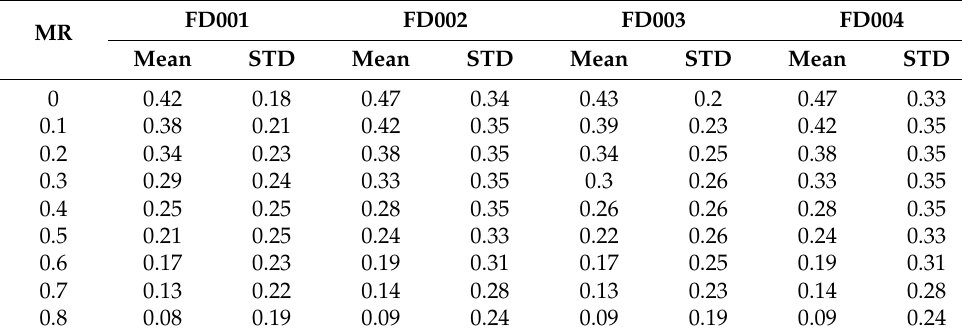
Table 2. The mean and STD of dataset under different missing rates